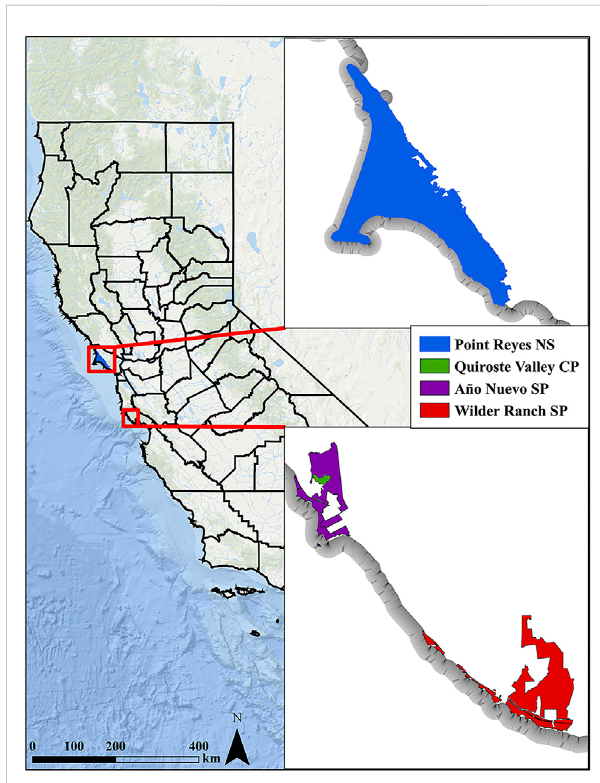
FIGURE 1 Overview of the central California coast with study areas discussed. Speci fi c locations of the archaeological sites have been omitted to protect these sensitive cultural